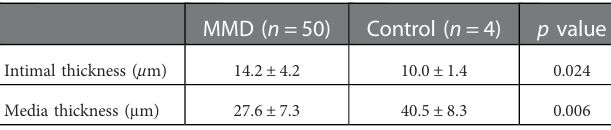
TABLE 4 Intimal and media thickness of middle cerebral arteries of patients with moyamoya disease.